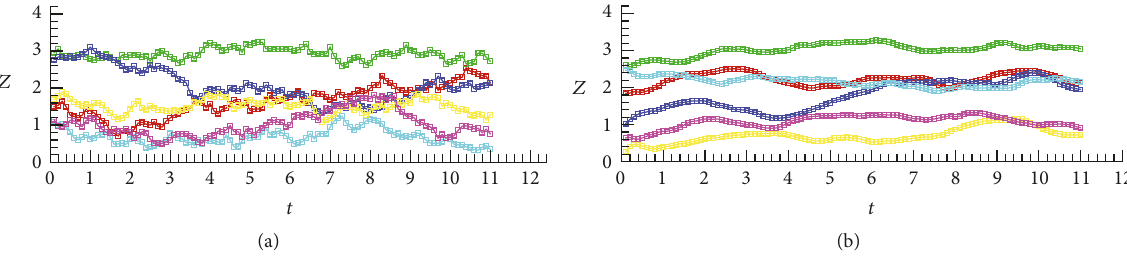
Figure 9: Trajectory of 6 sampled RBCs expressed in Z coordinate: (a) high shear rate ( 𝛾 = 100/s) and (b) low shear rate ( 𝛾 = 10/s); high shear rates tend to show more high frequency fluctuations, while low shear rates show smooth variations.